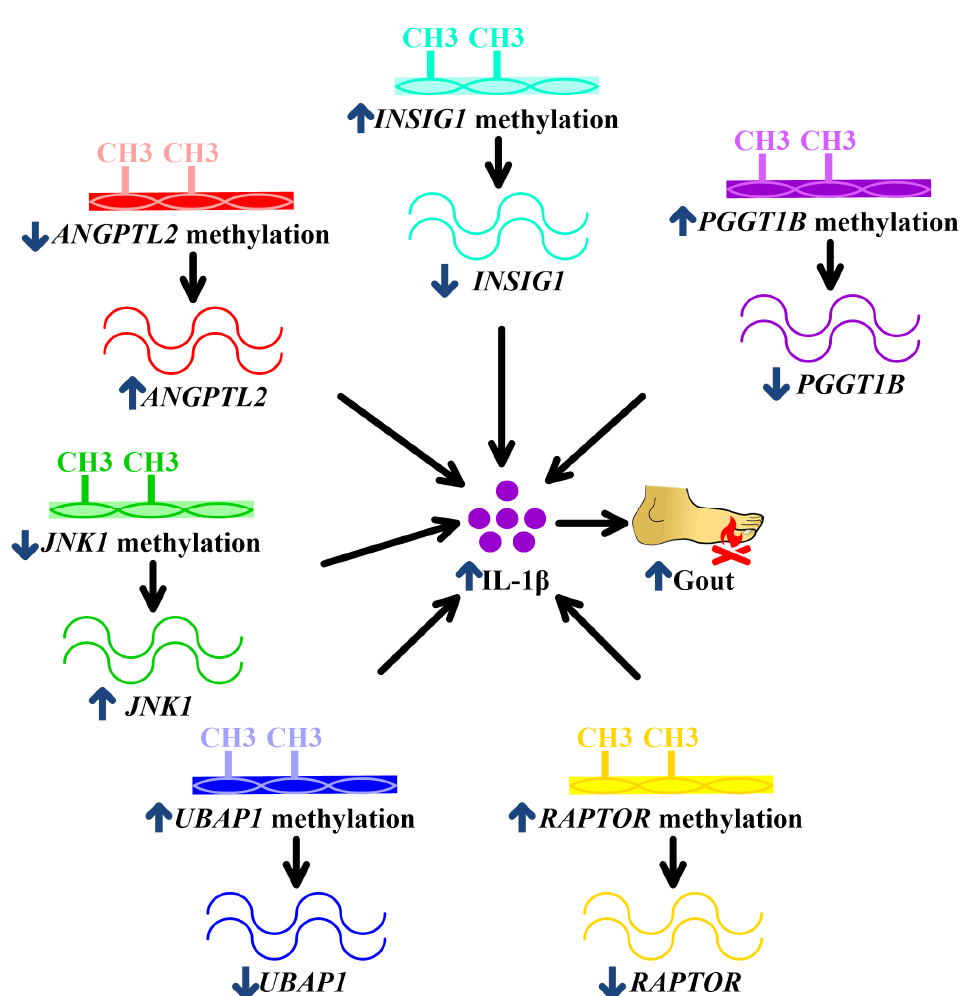
Figure 5. Potential mechanisms underlying associations of PGGT1B , INSIG1 , ANGPTL2 , JNK1 , UBAP 1, and RAPTOR methylation with gouty inflammation. PGGT1B hypermethylation in gout decreases PGGT1B, INSIG1 hypermethylation in gout reduces INSIG1 , ANGPTL2 hypomethylation enhances ANGPTL2 , hypomethylated JNK1 increases JNK1 , UBAP 1 hypermethylation downregulates UBAP1 , and hypermethylated RAPTOR represses RAPTOR . All of these culminate in augmented IL-1β production, facilitating gouty inflammation. The blue arrows mean the change of methylation or expression or development of gout. The black arrows mean the consequence of methylation or expression alterations.